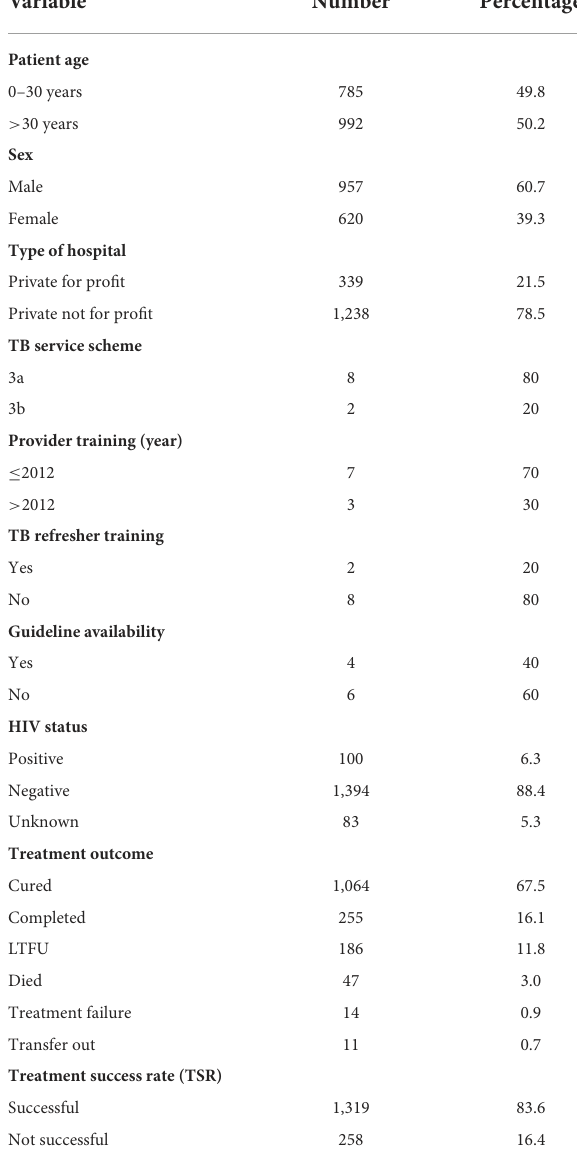
TABLE 1 Demographic characteristics and reported treatment outcomes for TB patients who initiated treatment across 10 private hospitals in Lagos State between January–December 2016 ( n = 1,577).